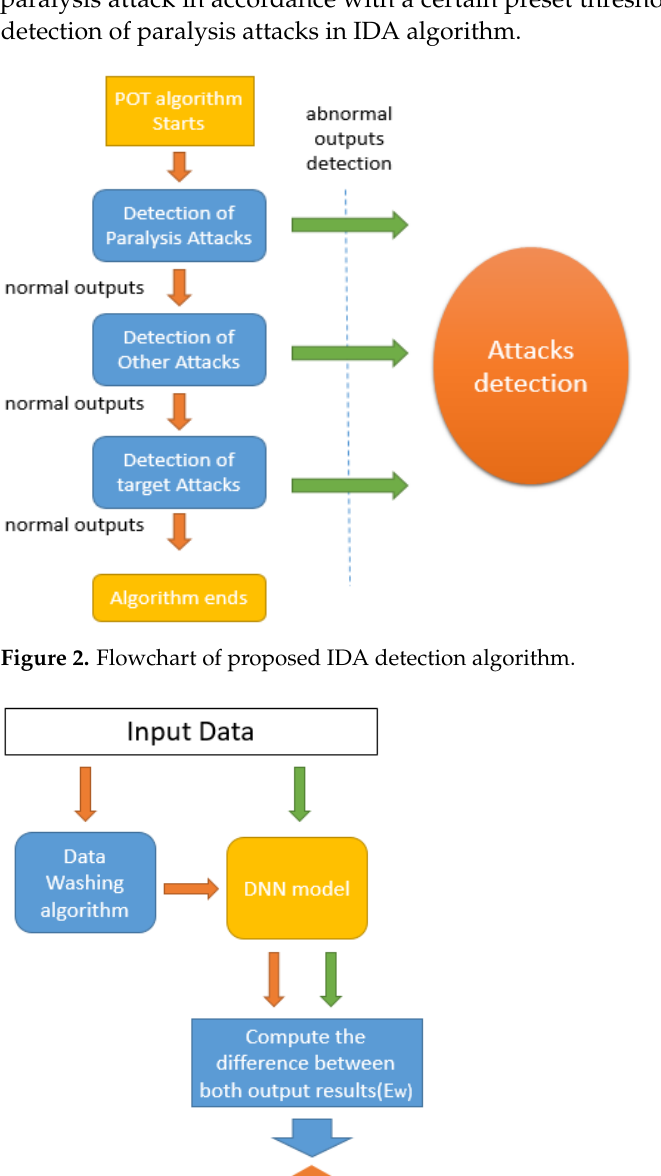
Figure 4. Flowchart showing detection of other attacks in IDA algorithm. Detection of Target Attacks: The goal of target attacks is to make the outputs of the penultimate layer of the learning model be the same for the training data and testing data, respectively. In other words, the training dataset and target data appear to be the same to the ML model even though their resulting labels are actually different. That is, the ML model misclassifies the true label of the testing data point. Consequently, poisoned data points can be identified by comparing the outputs of the penultimate layer of the model